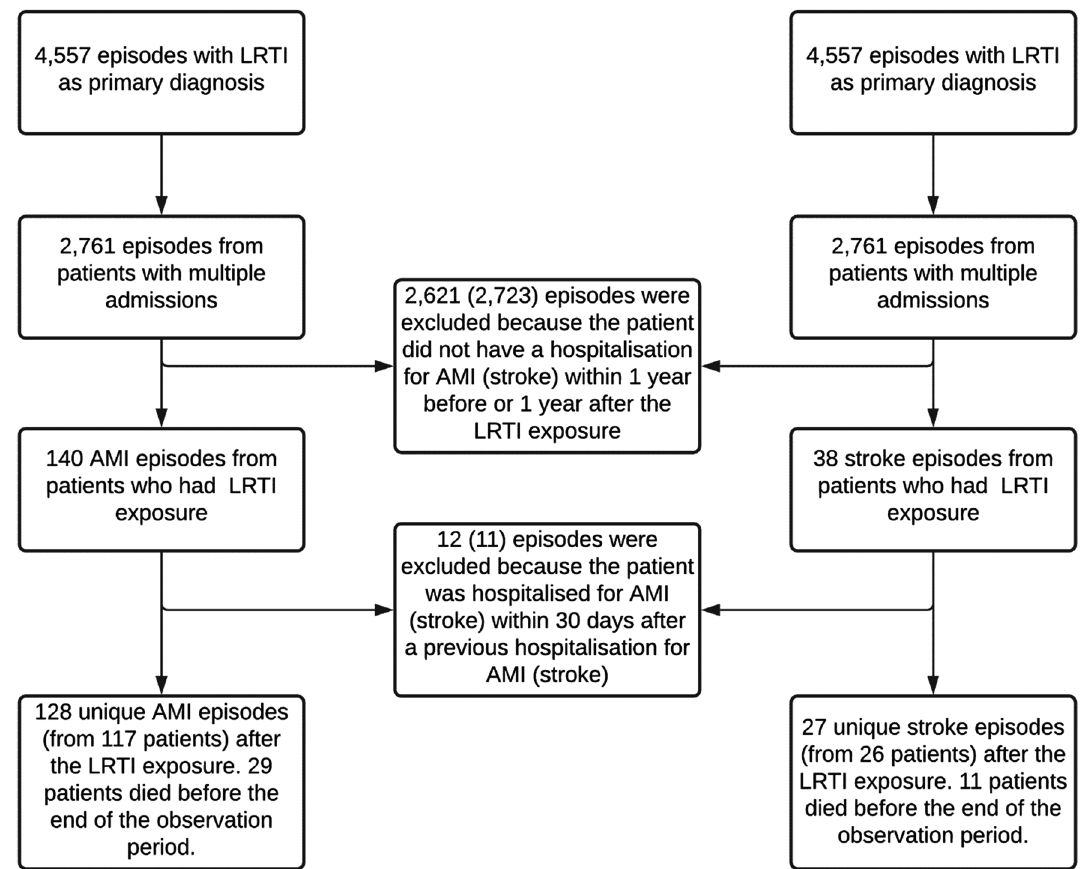
Figure 1. AMI and Stroke admissions included in the